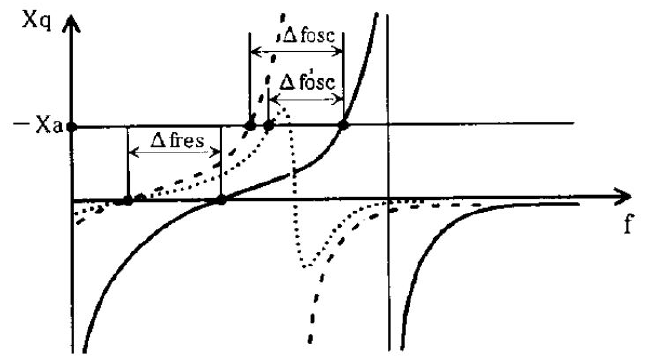
Figure 21. Dependency of reluctance upon frequency, solid line: no coating and no sorption. Thick dashed line: only mass loading without loss increase. Thin dash line: mass loading with additional loss. X a is the circuit reactance at the oscillating point. Oscillation frequency deviates from actual resonant frequency change when loss increases. © 2021 IEEE. Reprinted with permission from 1996 Proceedings of the IEEE Ultrasonics Symposium, 1996, Volume 1, No. 22, pp. 351–354